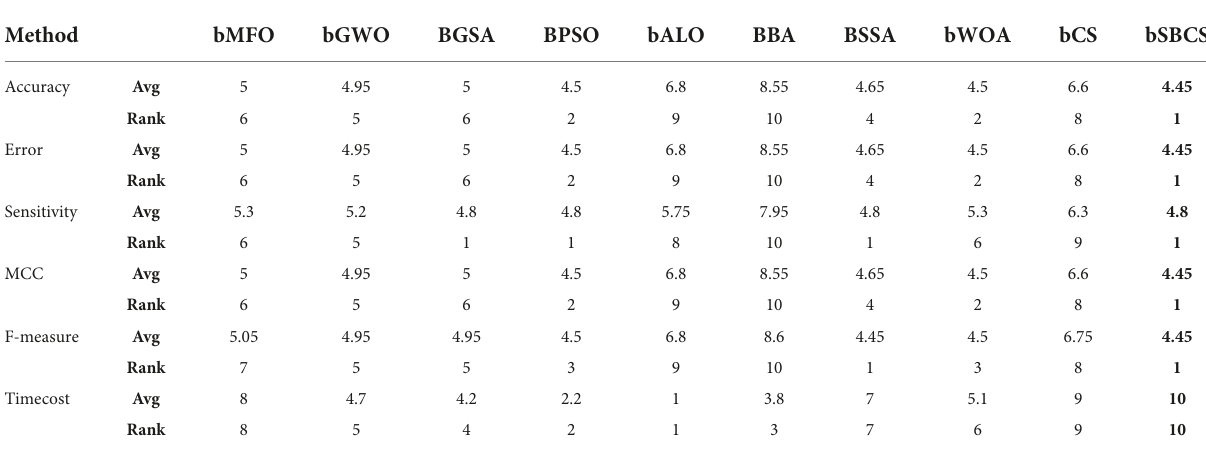
TABLE 13 Freidman test